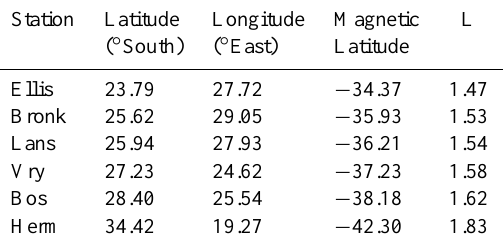
Table 1. Geographic latitude and longitude, corrected geomagnetic latitude, and L-shell location for the various stations Station Latitude Longitude Magnetic L ( ◦ East) Latitude